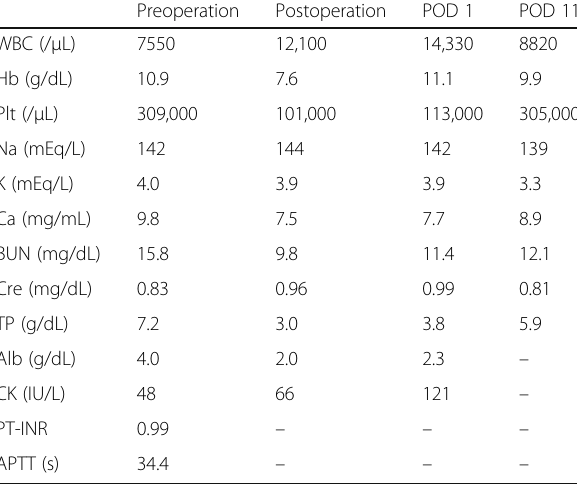
Table 1 Changes in the results of blood examinations Preoperation